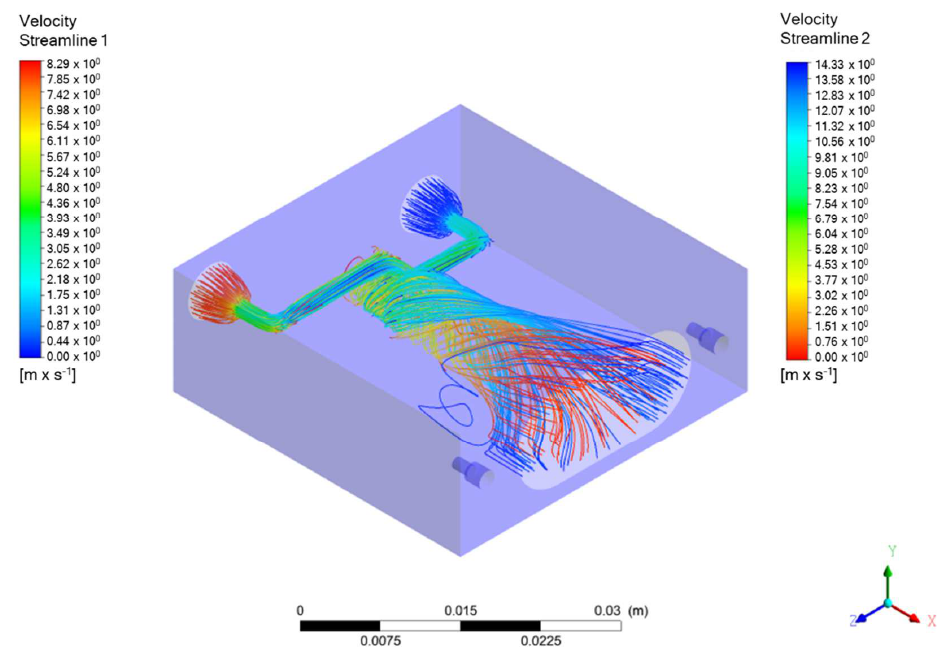
Figure 10. Horizontal vortex combustor velocity streamline.